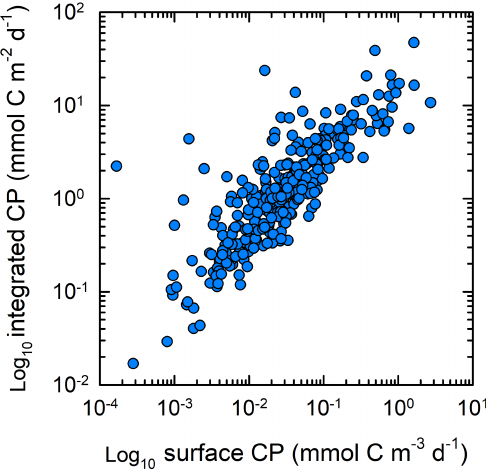
Figure 6. Scatterplot of log-normalised surface ( < 20m) CaCO 3 production (CP) and euphotic zone log-normalised integrated CP. The relationship between the two is statistically significant (Pear- son’s product-moment correlation, r = 0 . 83, p < 0 . 001, n =